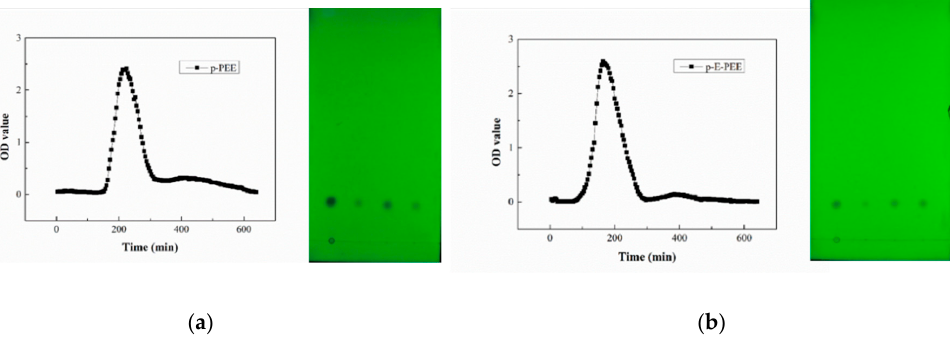
Figure 3. ( a ) UV detection. ( b ) TLC detection (the sample points in the two TLC plates, from left to right, are standard hydroxyl- α -sanshool and the starting point, peak point, and end point of the target fractions, respectively).